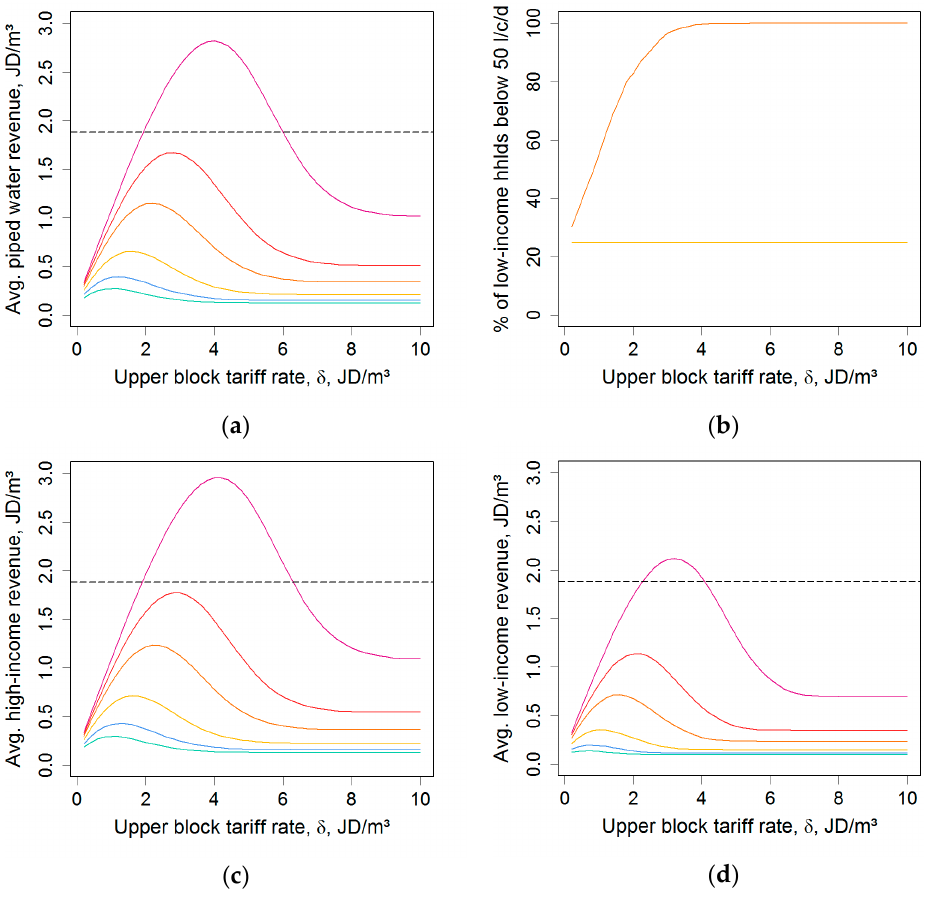
Figure 4. Results of simulation experiment 3, analyzing a two-block tariff consisting of one block free of charge, followed by a second block with a uniform tariff rate, where the boundary between the two blocks is defined in liters per person per day: For various levels of the upper block tariff rate ( δ ) , ( a ) shows the average revenue per m 3 paid by all households; ( b ) shows the percentage of low-income households consuming less than 50 L per person per day; and ( c ) and ( d ) show the average revenue per m 3 paid by high and low income households, respectively. The colored curves indicate the following levels of the tariff increase threshold ( γ ) , measured in liters per person per day: pink = 10; red = 20; orange = 30; yellow = 50; blue = 75; green = 100. The dotted lines mark the financial costs of water provision of 1.882 JD/m 3 . Axis labels: l/c/d = liters per capita per day; hhlds = households.